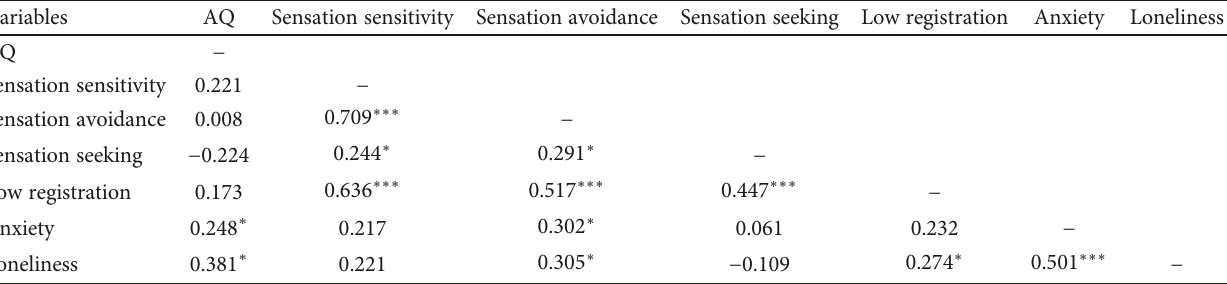
Table 2: Intercorrelations of sensory processing, anxiety, and loneliness.